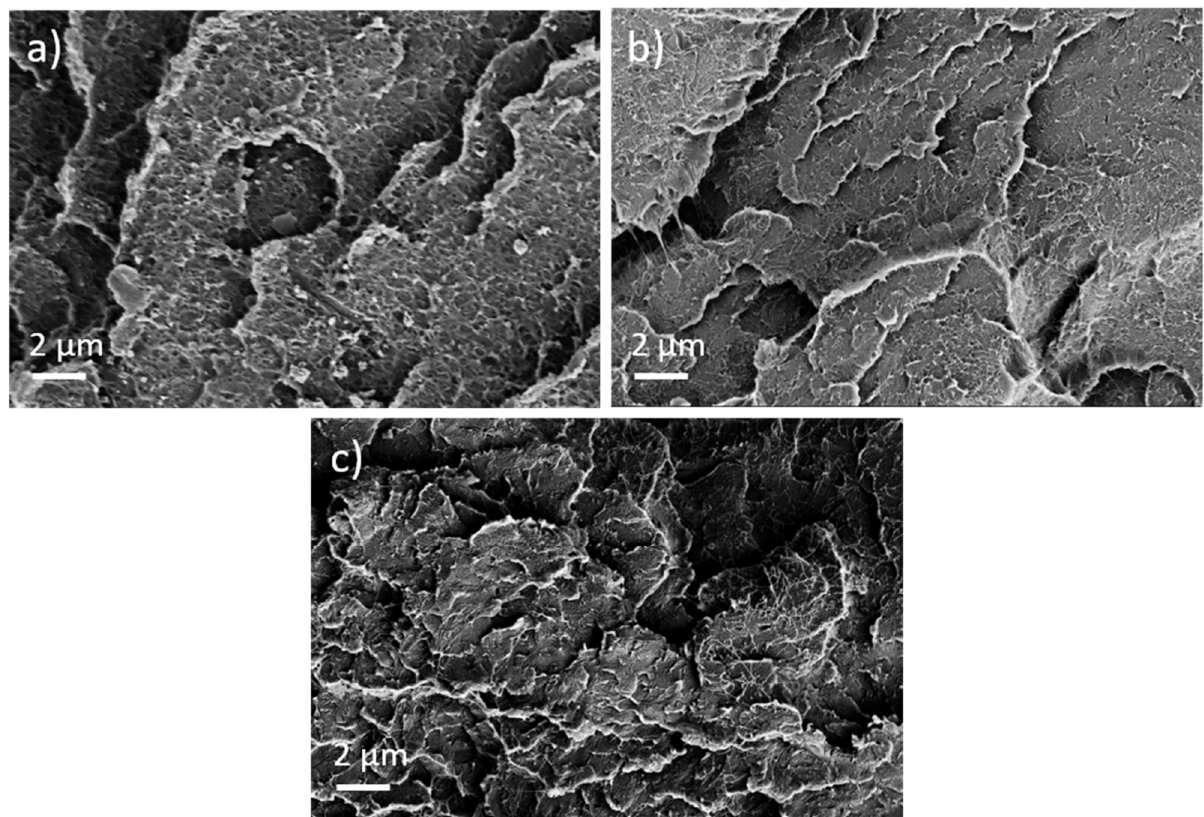
Figure 6. Scanning electron microscopy images of cryo-fractured surfaces of ( a ) PC/2 wt% Tuball TM